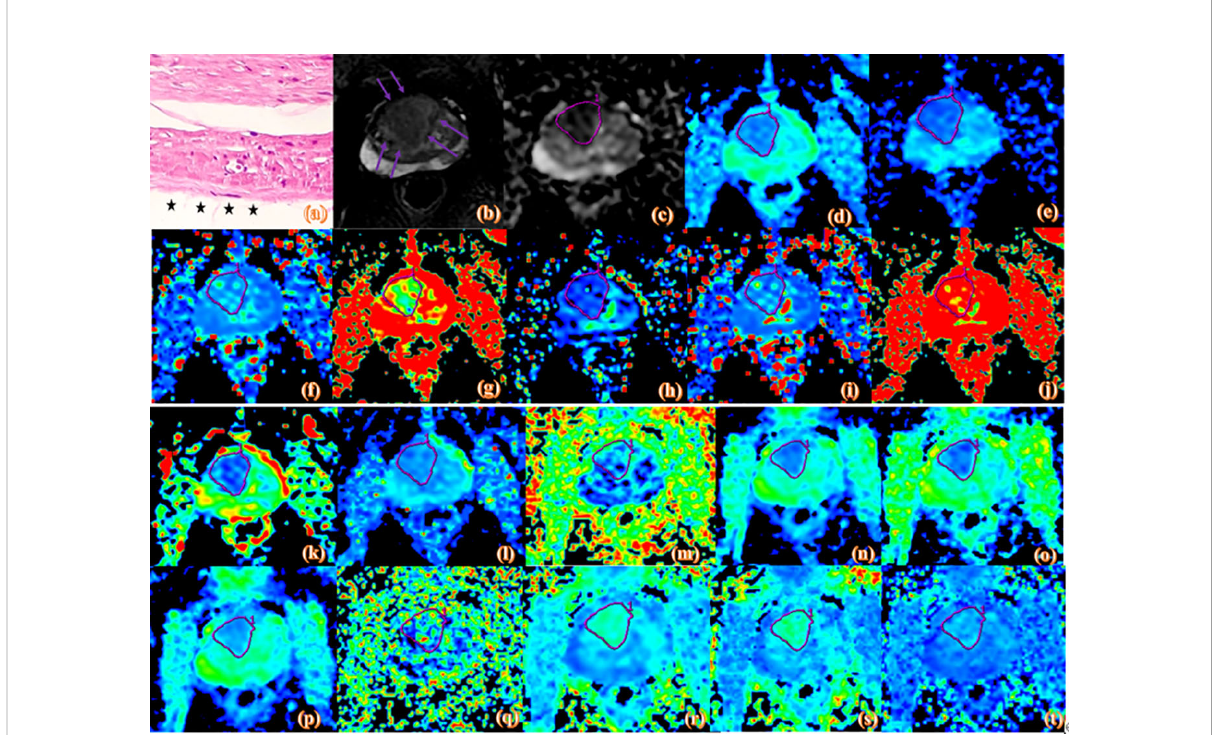
FIGURE 2 Pathologic and MR parametric maps of a 77-year-old patient (PSA level, 46.4 ng/mL; postoperative Gleason score, 3 + 4 = 7) with negative surgical margins. No neoplastic cells are seen at the ink mark of the margin indicated by the black star on the histologic map (20 × 10 magni fi cation). (A) . T2WI map is shown (B) , lesion is indicated by pink arrows. ADC map is shown (C) , IVIM maps are shown (D – L) and DKI maps are shown (M – T) . Lesions are indicated by pink ROI. ADC ME value is 0.989×10 -3 mm 2 /s, ADC BE value is 0.716×10 -3 mm 2 /s, D mono value is 0.462×10 -3 mm 2 /s, D* mono value is 0.0046 mm 2 /s, f mono value is 0.426%, D Bi value is 0.417×10 -3 mm 2 /s, D* Bi value is 0.0044 mm 2 /s, f Bi value is 0.486%, DDC value is 0.975×10 -3 mm 2 /s, a value is 0.671, FA value is 0.261, MD value is 1.22 um²/ms, Da value is 1.55 Am²/ms, Dr value is 1.06 um²/ms, FAk value is 0.404, MK value is 0.791, Ka value is 0.91, and Kr value is